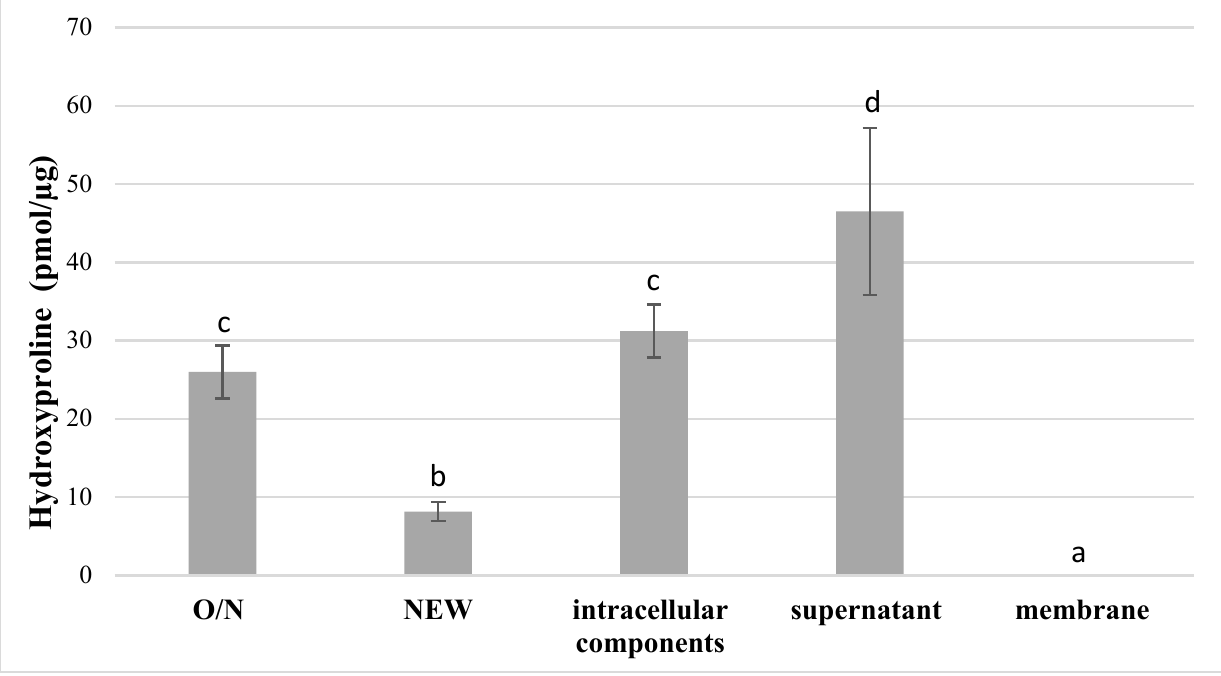
Figure 1. Hydroxyproline production after incubation of type I collagen with O/N and NEW S. mutans UA159 and its discrete fractions (n = 3; data are reported as mean ± standard errors). Different lowercase letters indicate statistically significant differences between the groups. Values with the same letters indicate non-significant differences ( p > 0.05). O/N: overnight cultures; New: 1:100 fresh inoculated cultures.